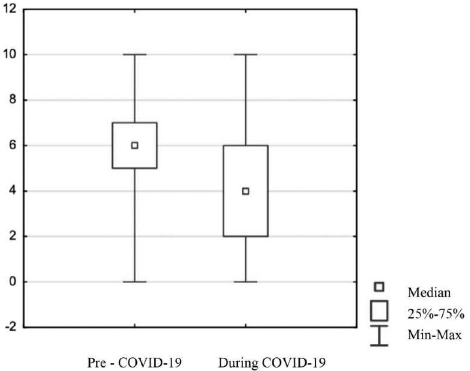
Figure 6. Comparison of scores concerning the quality of health services before and during the COVID-19 pandemic among